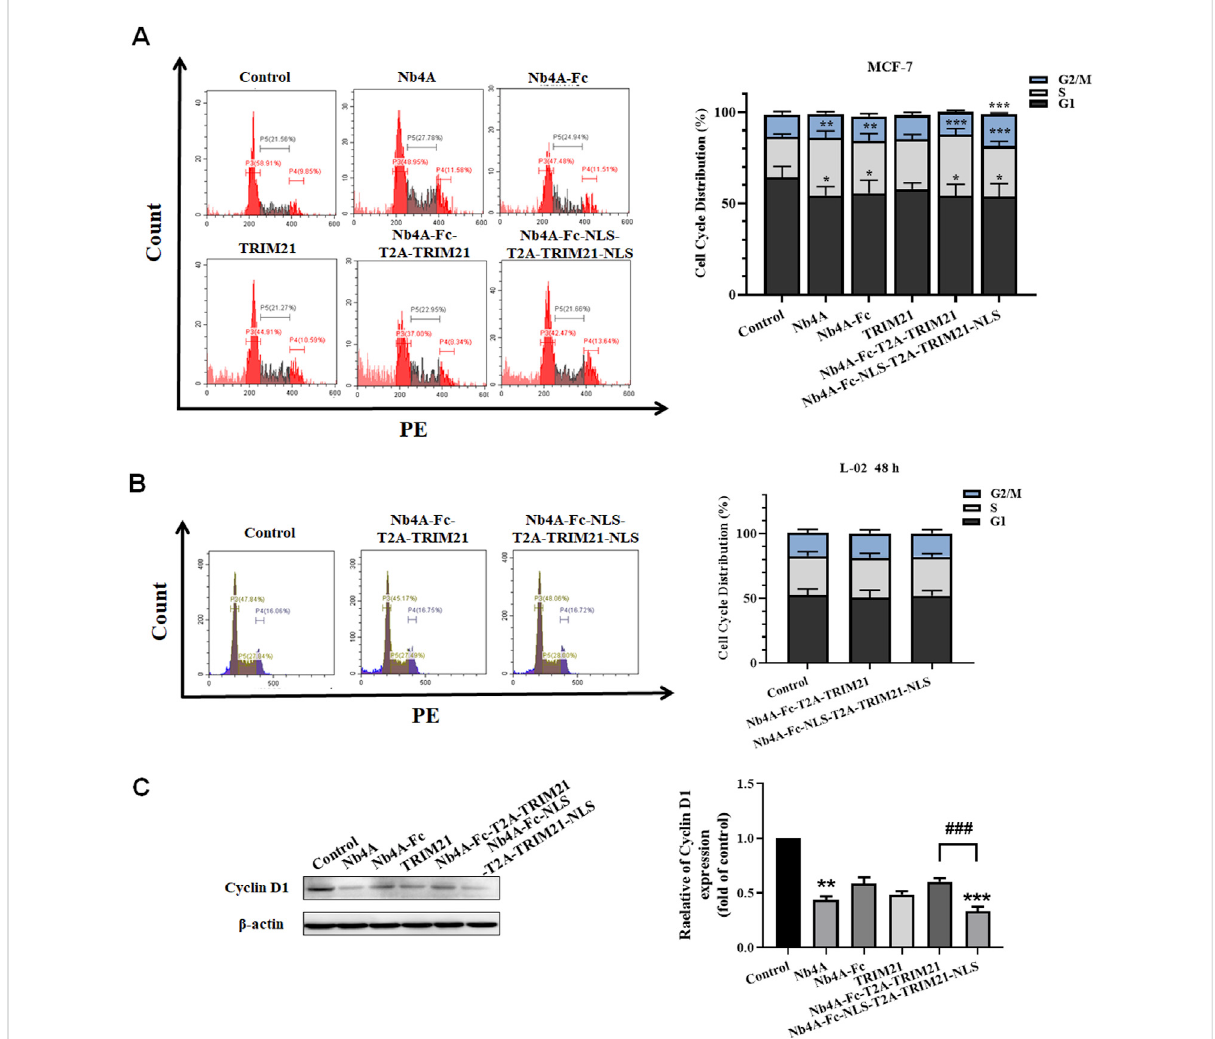
FIGURE 7 Effectsofsurvivindegradationindifferentsubcellsoncellcycle.CellcycleanalysisofMCF-7cellsandL-02cells. (A) CycledistributionofMCF-7 cells was measured by transfecting the recombinant plasmids pcDNA3.1(+), pcDNA3.1(+)-Nb4A, pcDNA3.1(+)-Nb4A-Fc, pcDNA3.1(+)-TRIM21, and pcDNA3.1(+)-Nb4A-Fc-T2A-TRIM21 and the plasmid pcDNA3.1(+)-Nb4A-Fc-NLS-T2A-TRIM21-NLS for 48 h. The tacked column of cycle distributionis shown right. (B) Cycle distributionofL-02 cellswas measured bytransfectingtherecombinant plasmids pcDNA3.1(+)-Nb4A-Fc- T2A-TRIM21 and pcDNA3.1(+)-Nb4A-Fc-NLS-T2A-TRIM21-NLS for 48 h. The tacked column of cycle distribution is shown right. (C) Cyclin D1expressionwasdeterminedinMCF-7cells.TheproteinbandsofcyclinD1werenormalizedto β -actin,andtheresultsareshownright( n =3).* p < 0.05, ** p < 0.01, and *** p < 0.001 versus control and ### p < 0.01 versus the Nb4A-Fc-NLS-T2A-TRIM21-NLS group. Data are expressed as mean ±